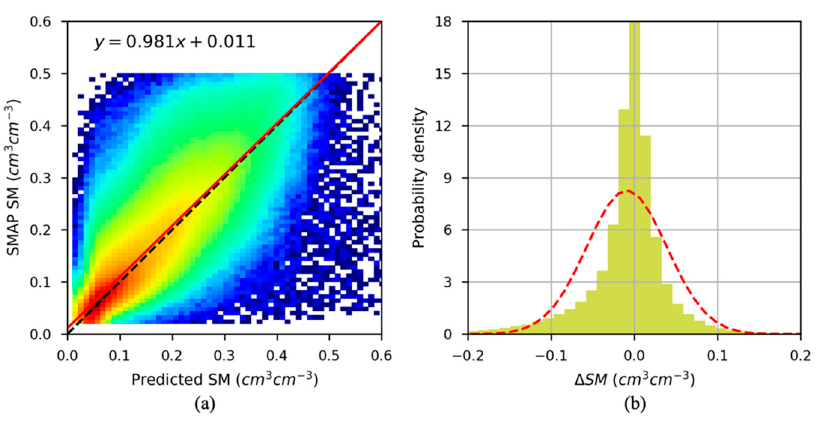
Figure 6. Density scatterplot of GNSS-R derived SSM and SMAP SSM ( a ) and probability density distribution of inversed SSM deviation ( b ).